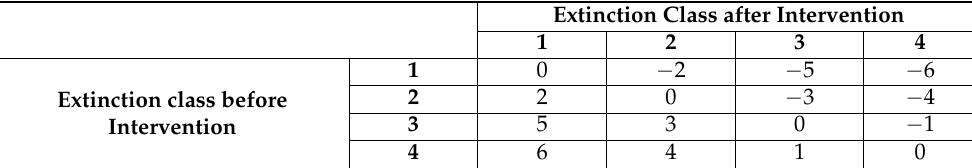
Table 5. Degrees of improvement assigned to changes in extinction